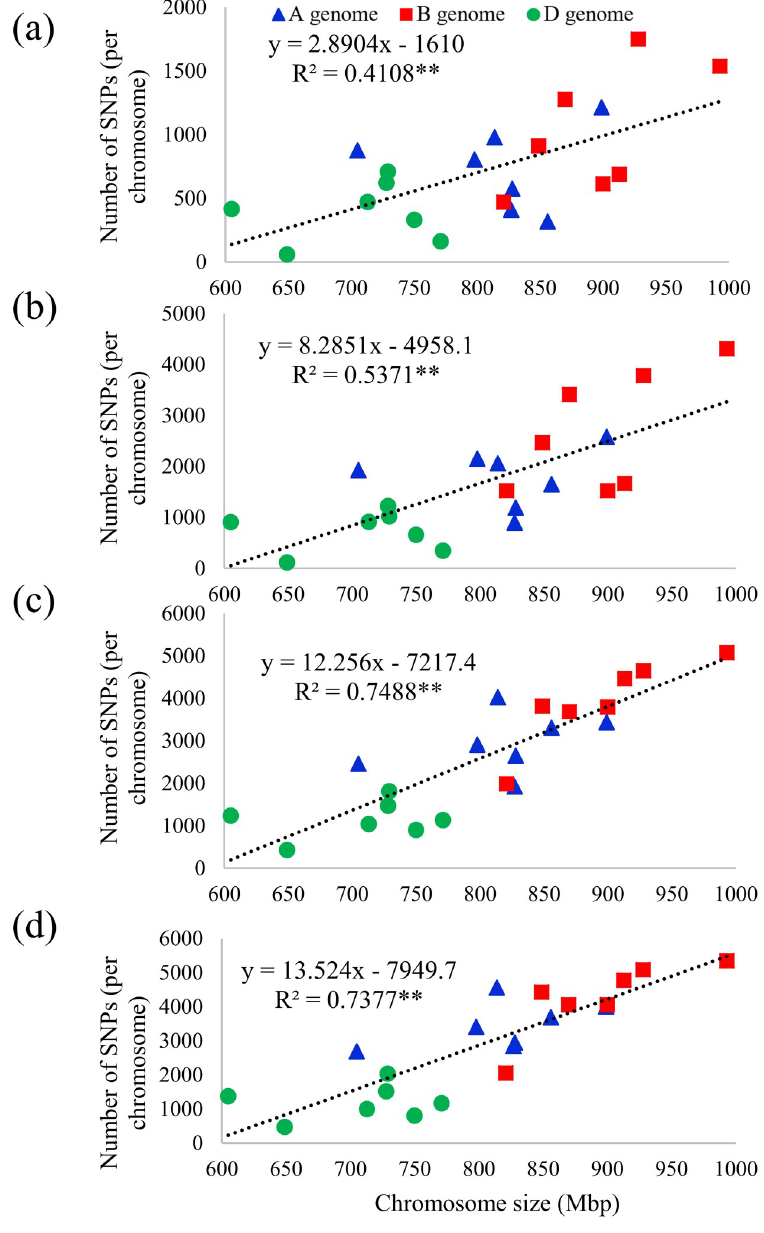
Fig 2. Relationship between the number of SNPs per chromosome and chromosome sizes when (a) barley genome, (b) Chinese Spring survey sequence (CSSS), (c) W7984, and (d) IWGSC RefSeq v1.0 reference was used to call